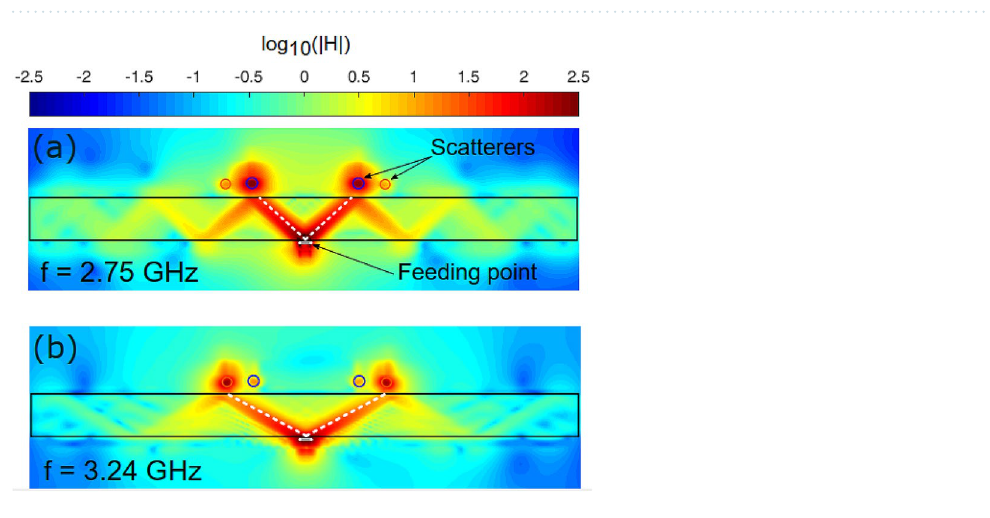
Figure 3. Electromagnetic energy extraction from hyperbolic metamaterial slab. Logarithmic color maps (arbitrary units) of the magnetic field amplitude (|H|) at two different frequencies of the excitation ( a ) 2.75 GHz. ( b ) 3.24